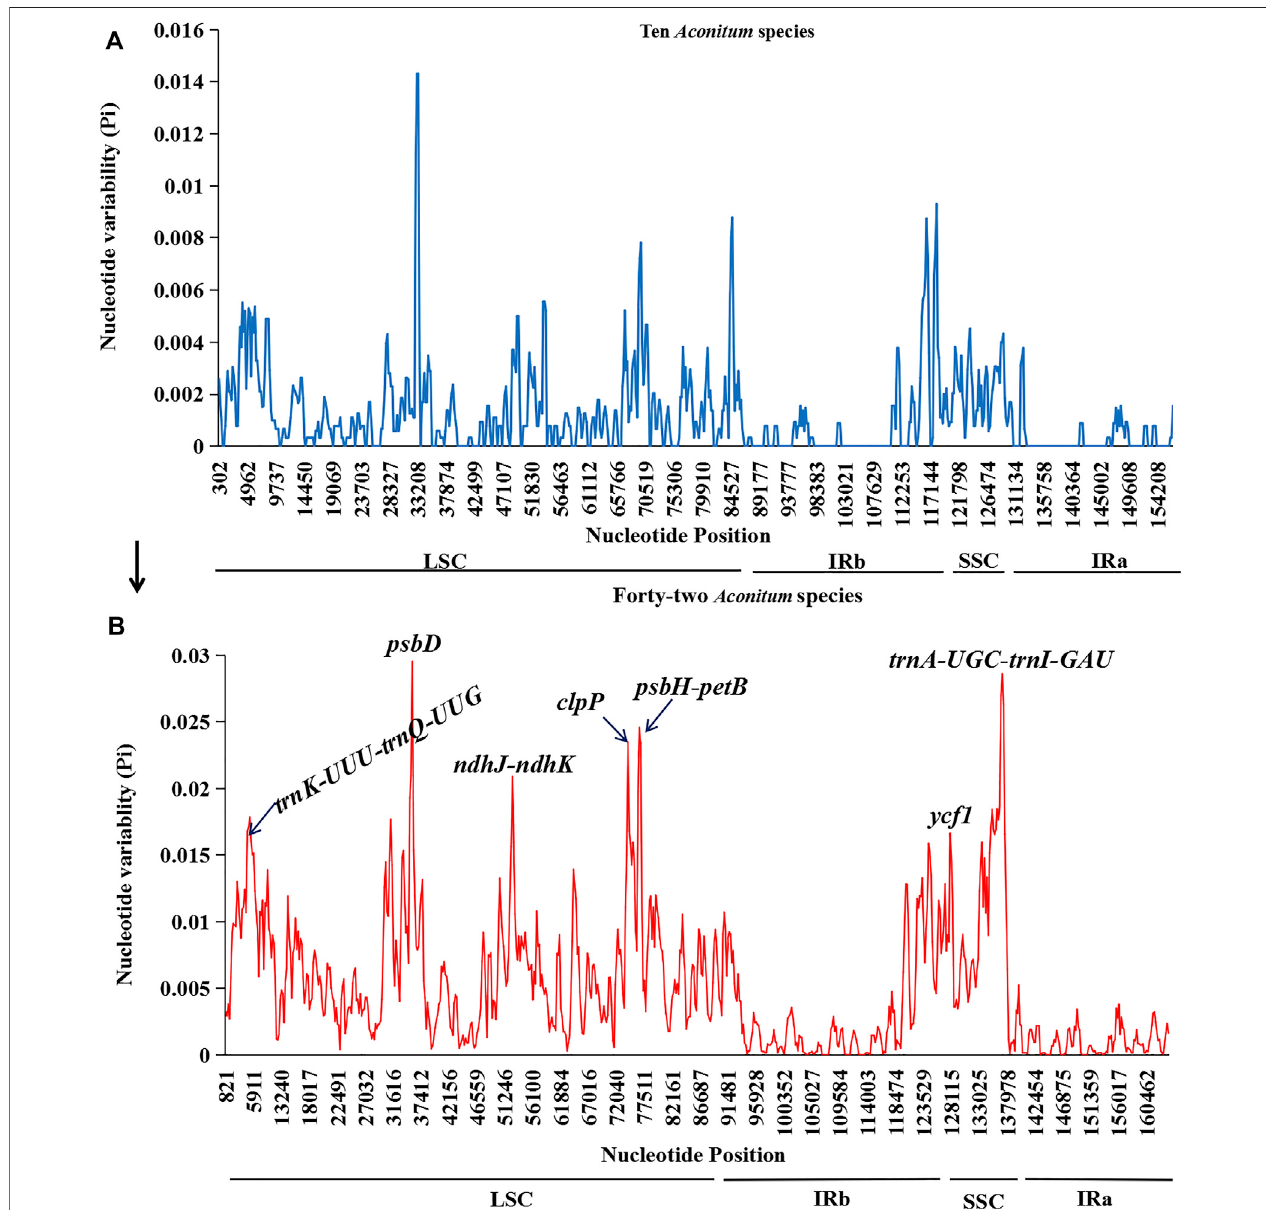
FIGURE 10 | Sliding window analyses of the whole plastomes of Aconitum species. X-axis: position of the midpoint ofa window, Y-axis: nucleotide diversity (Pi) of each window. (A) : Sliding window analysis of ten Aconitum species sequenced in this study. (B) : Sliding window analyses the whole plastomes of 42 Aconitum species (comprising ten species for this